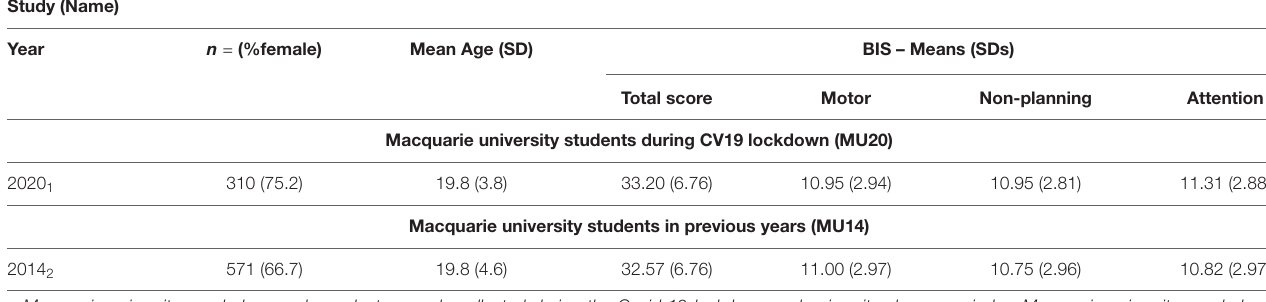
TABLE 11 | Comparison of the current sample with a previous student sample for the short form Barratt Impulsiveness Scale (BIS). Comparison MANCOVA (age as covariate), Sample (S), Gender (G) Gender × Sample MU20 vs.